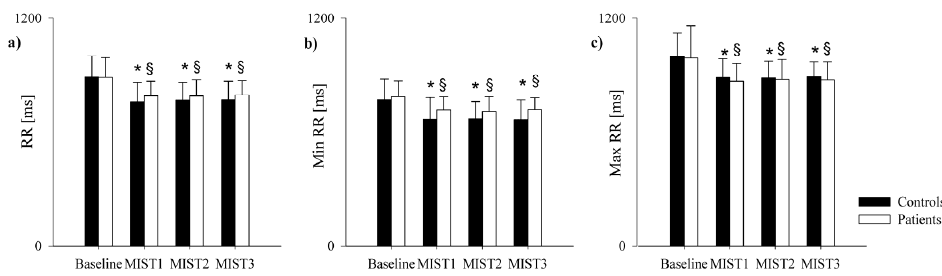
Figure 3. Comparison of the ECG-derived parameters in healthy controls and PAH patients during the experimental sessions. The bar graphs show the mean RR (panel a ), minimum RR (panel b ) and maximum RR (panel c ) recorded in healthy controls (black bars) and in PAH patients (white bars) in resting condition (Baseline) and during the three different blocks of the Montreal Imaging Stress Test (MIST1, MIST2 and MIST3). Results are presented as mean ± standard deviation. * indicates p < 0.05 vs. Baseline in the control group, and § indicates p < 0.05 vs. Baseline in the PAH patients’ group.